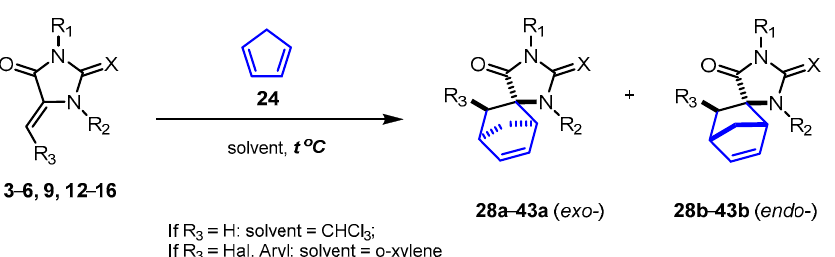
Scheme 3. Reactions of methyleneimidazolones with Table 1. Diels–Alder reactions of methylideneimidazolone derivatives with cyclopentadiene.